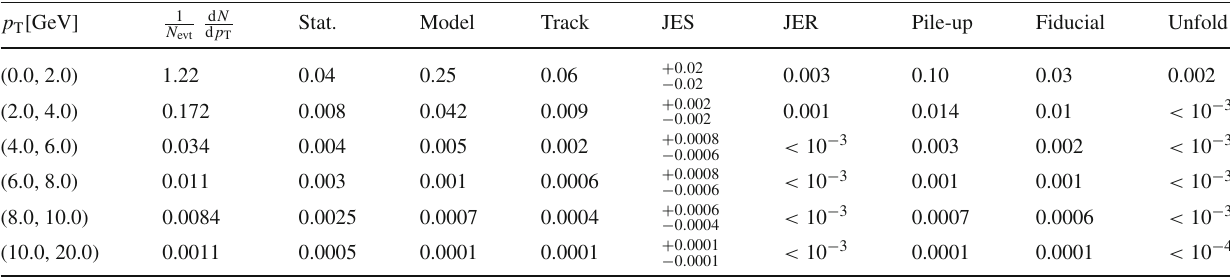
not associated with jets, and including invisible decays, along with S